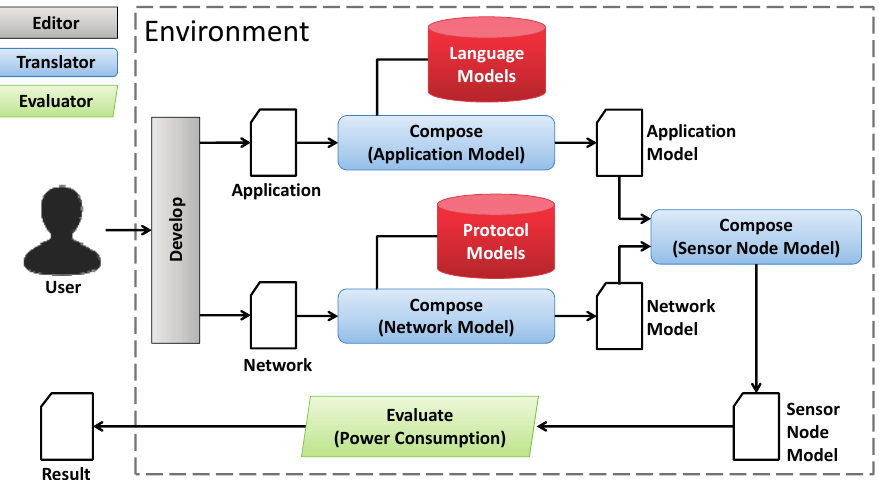
Figure 2. Step-by-step to evaluate the power consumption of